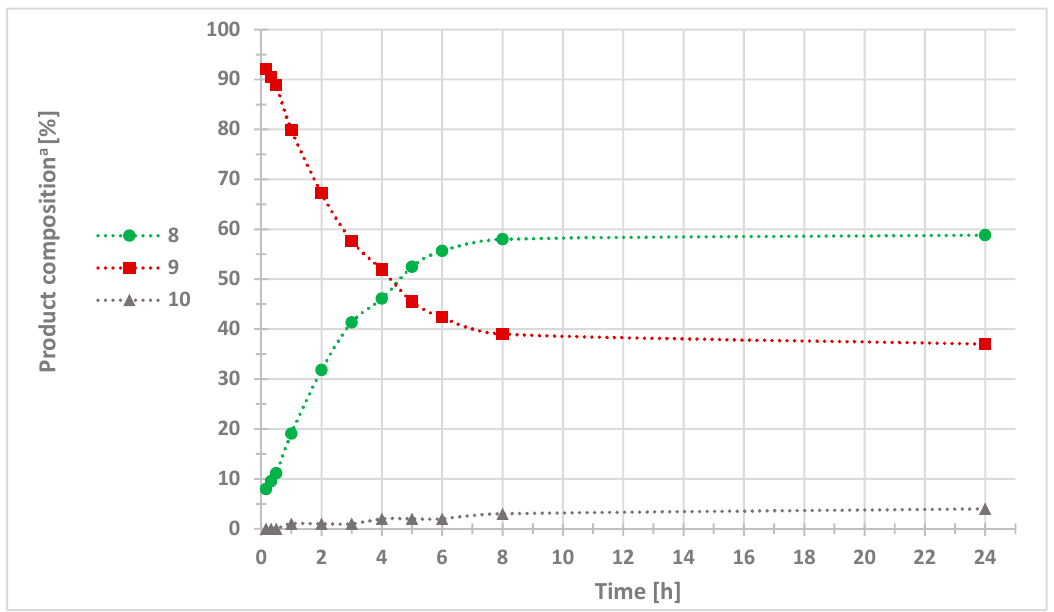
Figure 1. Time dependence of the product composition in the model reaction of phenylacetylene, benzyl azide and dibutyl phosphite. Conditions: phenylacetylene (1 equiv.), benzyl azide (1.1 equiv.), dibutyl phosphite (2 equiv.), CuCl (0.1 equiv.) and TEA (2 equiv.) were stirred in MeCN with continuous air bubbling at 25 °C for 24 h. a Based on HPLC (222 nm).